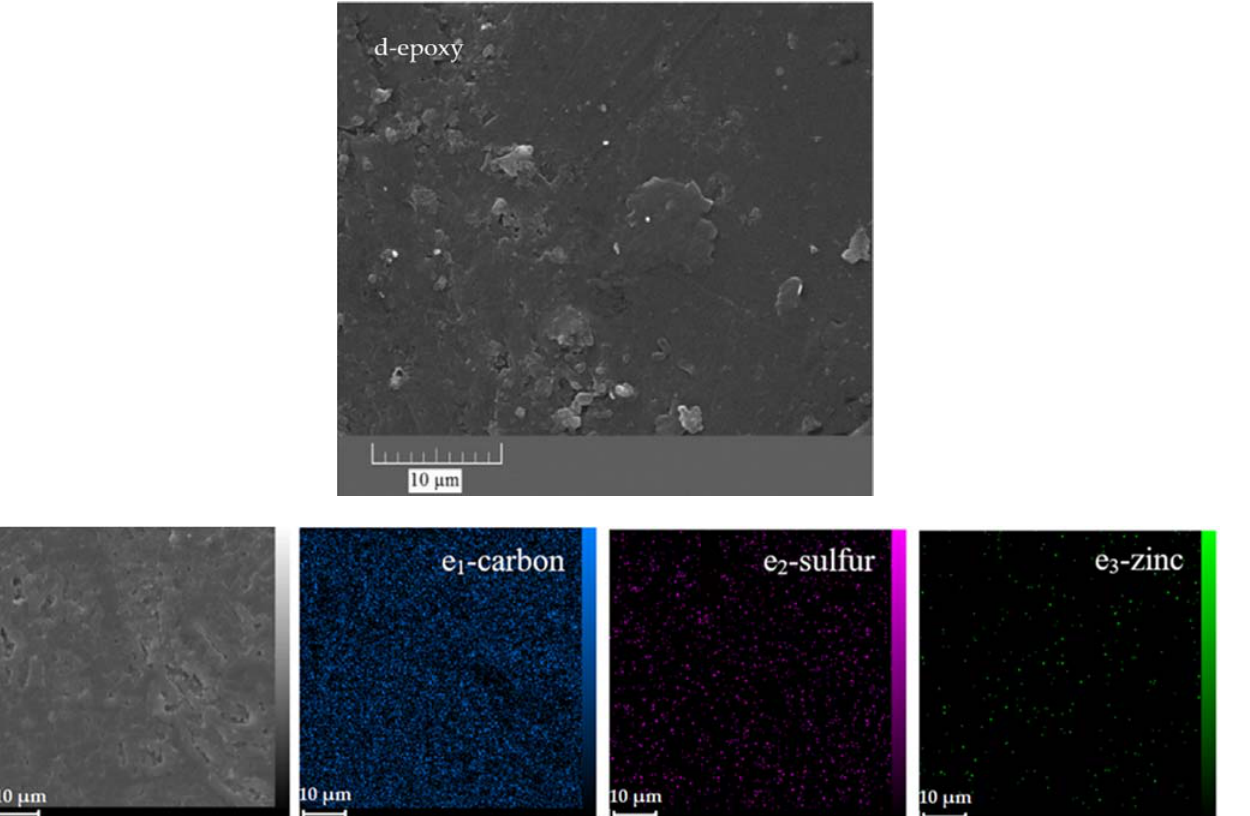
Figure 13. FESEM and EDS-mapping images of the neat ( a , b , c 1–5 ) and ZHS-containing ( d , e 1–3 ) epoxy coatings after corrosion tests.